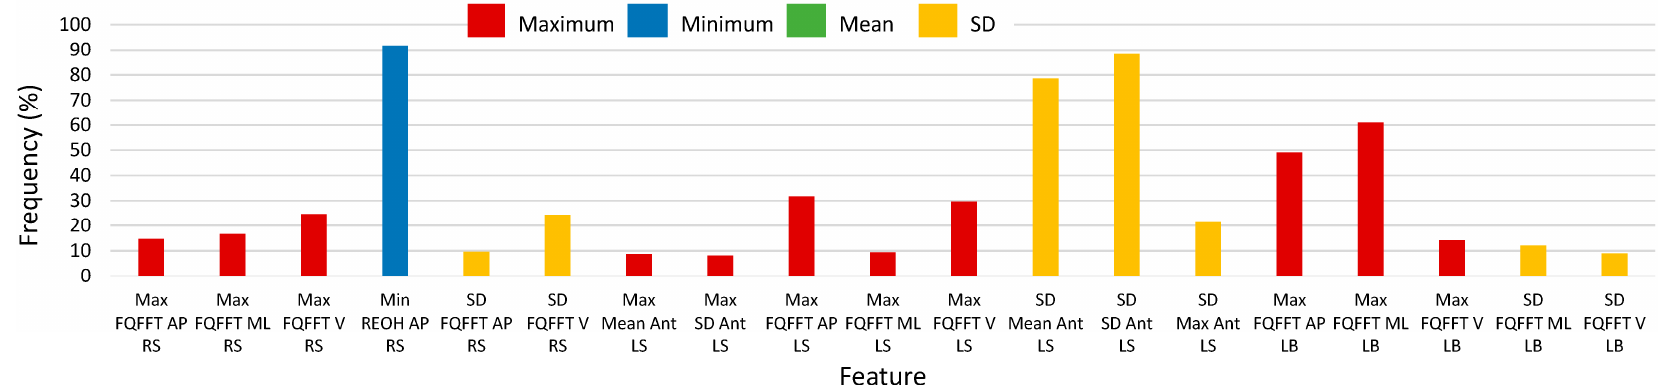
Figure 8. Histogram of selected turn-based feature frequency above 8% (200) of 2500 total selections using the combination of Select False Positive Rate and Select False Discovery Rate methods (SEL) for 2500 random-shuffle-split iterations.